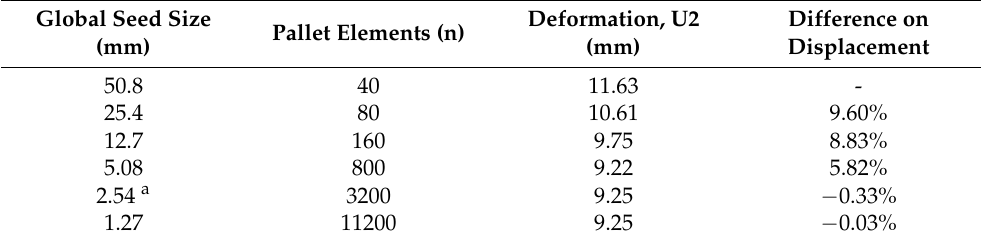
Table 4. Mesh convergence for pallet simulator for maximum deflection.